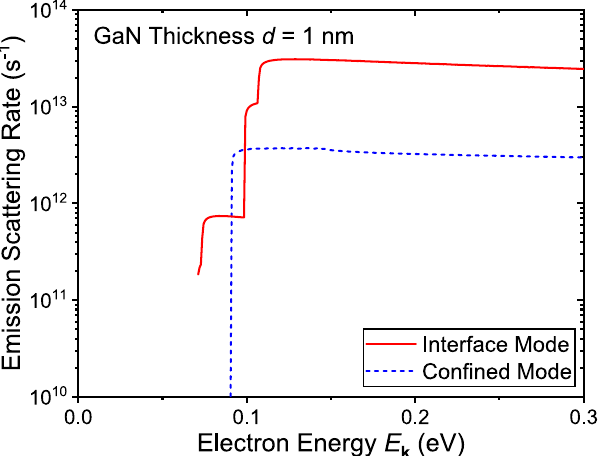
Figure 5. Interface and confined mode phonon emission scattering rates of a AlN/GaN/AlN double heterostructure with GaN thickness of d = 1 nm is plotted. Compared to the d = 5 nm case, the interface mode scattering rate (red solid line) show a factor of 3 increase, whereas the confined mode scattering rate (blue dashed line) show a factor of 2.5 decrease. Overall, the interface phonon scattering rate is approximately 8 times larger than the confined mode scattering rate with GaN thickness of d = 1 nm.